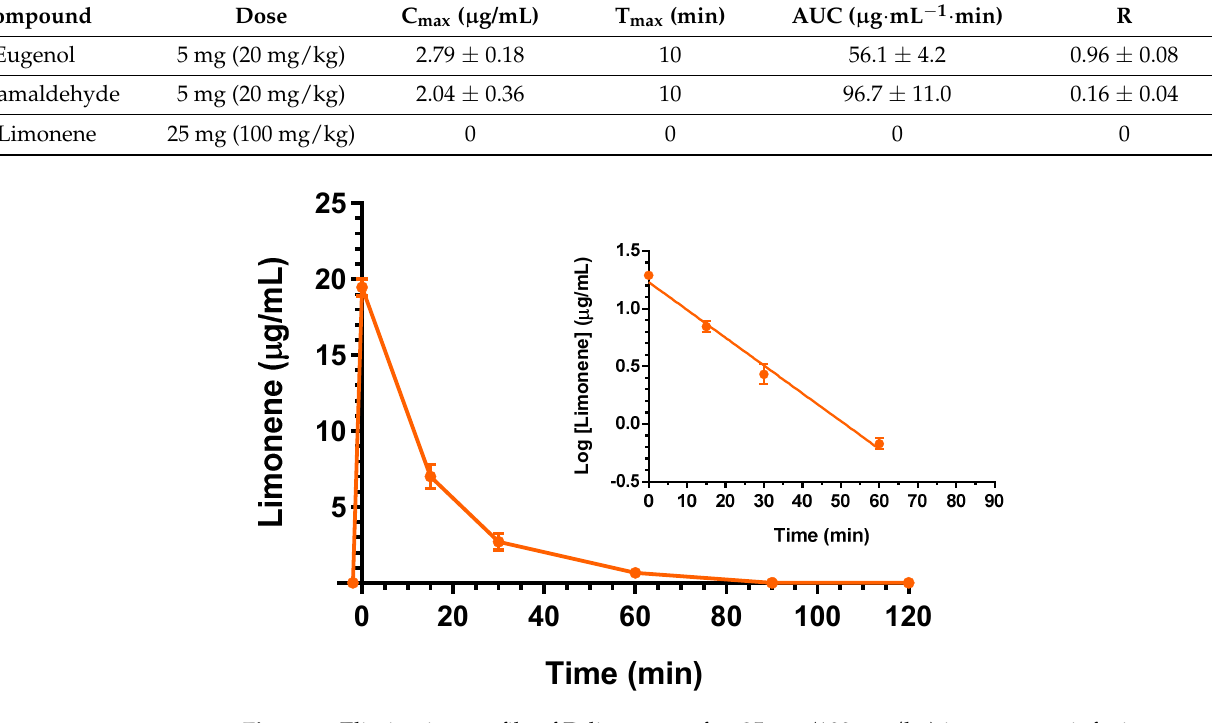
Figure 5. Elimination profile of D-limonene after 25 mg (100 mg/kg) intravenous infusion to rats. Data are expressed as the mean ± SE of four independent experiments. The elimination followed an apparent first order kinetics, confirmed by the semilogarithmic plot reported in the inset ( n = 4, r = 0.995, p < 0.01). The half-life of D-limonene was calculated to be 12.4 ± 0.9 min. Table 2. Pharmacokinetic parameters referred to cerebrospinal fluid (CSF) of eugenol, cinnamalde- hyde and D-limonene after intravenous administration to rats. Data are reported as mean ± SE ( n = 4). C max : maximum concentration obtained in CSF; T max : time of C max ; AUC: area under concentration from the end of infusion to last time of detection; R: ratio of concentration between CSF and blood- stream at T max .